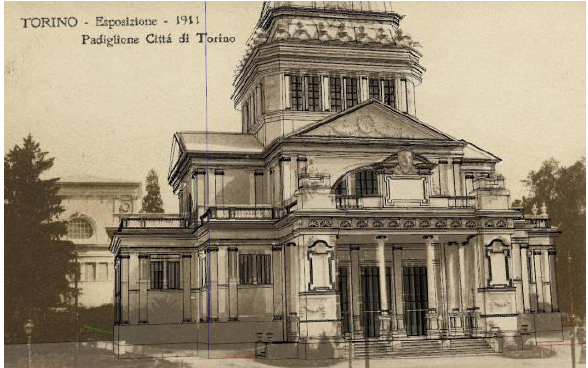
Figure 9. Image oriented with Match Photo tool to verify the model based on the original drawings